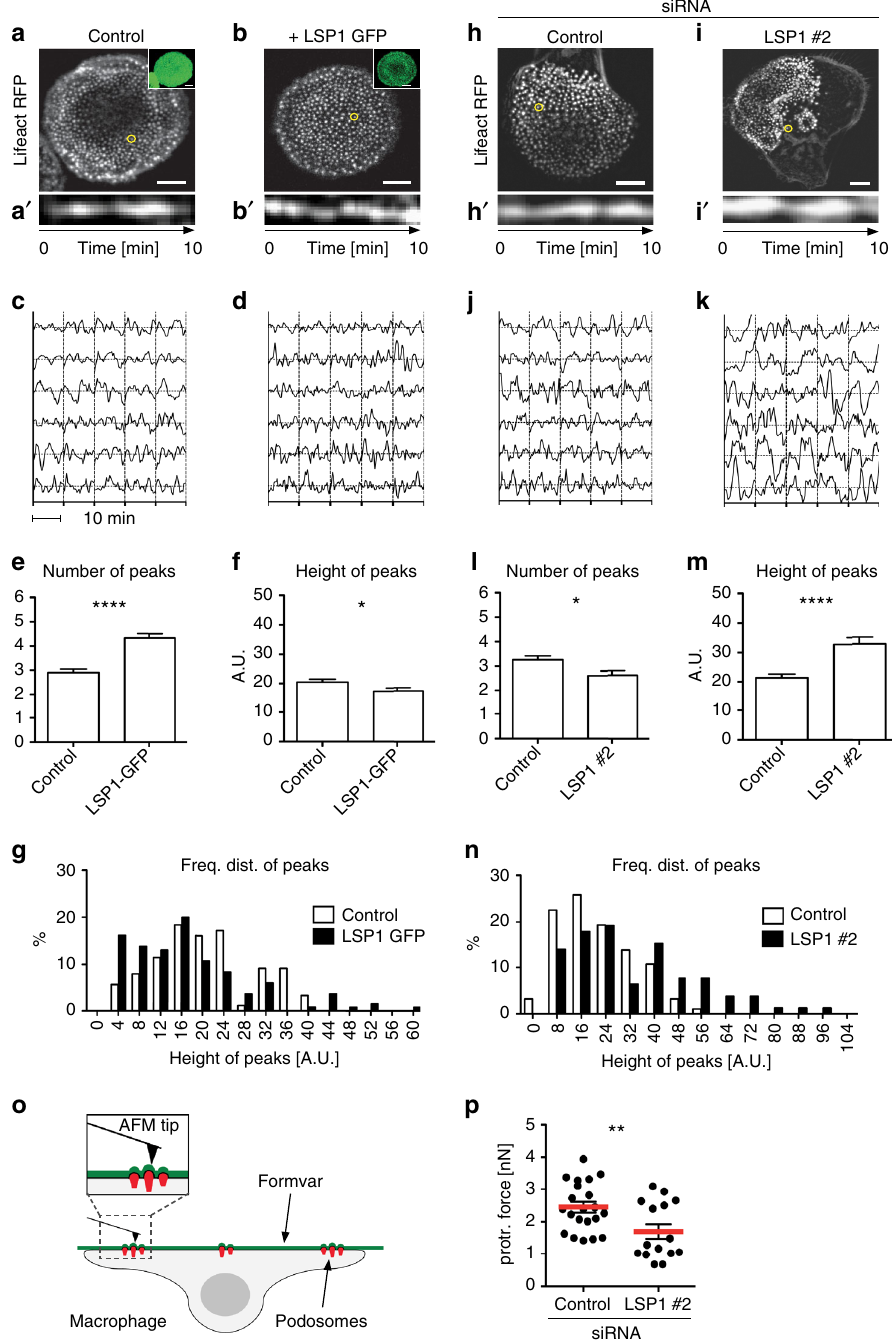
Fig. 3 LSP1 is a regulator of oscillatory podosome protrusion. a , b , h , i Podosome oscillation, determined by F-actin intensity measurements. Confocal micrographs of cells expressing lifeact-RFP and coexpressing EGFP ( a ) or LSP1-GFP ( b ), the latter shown as small insets in green, or treated with control ( h ) or LSP1-speci fi c siRNA ( i ). a ′ – b ′ , h ′ – i ′ Kymographs of F-actin intensities at single podosomes indicated by yellow circles in a , b , h , i . Time is indicated in min. c , d , j , k Normalized F-actin intensities at single podosomes in a fi xed plane of focus from EGFP control cells ( c ), LSP1-GFP expressing cells ( d ), or cells treated with control siRNA ( j ) or LSP1-speci fi c siRNA ( k ). Each row shows F-actin intensity curves of fi ve podosomes from a single cell, with 6 cells from from different donors analysed. Duration of each individual measurement: 10 min. e , f , l , m Statistical evaluation of F-actin based fl uorescence intensity fl uctuations, with e , l showing number of peaks and f , m showing height of peaks Data shown are Mean ± s.e.m.; *P < 0.05, **** P < 0.0001; two-tailed unpaired t -test. g , n Frequency distribution of peak height from graphs shown in c , d and j , k . Note different scale on x -axes due to broader frequency distributon in LSP1 kockdown cells. o Principle of protrusion force microscopy. A primary human macrophage is seeded on pliable Formvar matrix. Inversion of the setup allows probing of ventral macrophage surface, including oscillatory protruding podosomes, by atomic force microscopy (AFM). Modi fi ed from 48 . p Measurement of protrusion forces generated by single podosomes from cells treated with control or LSP1-speci fi c siRNA. Each dot represents the mean protrusion force of at least 23 podosomes (max 245) in a single cell. Data collected from two donors. Values are given as mean ± s.e.m. ** P < 0.01, two-tailed unpaired t -test. For speci fi c values, see Supplementary Data